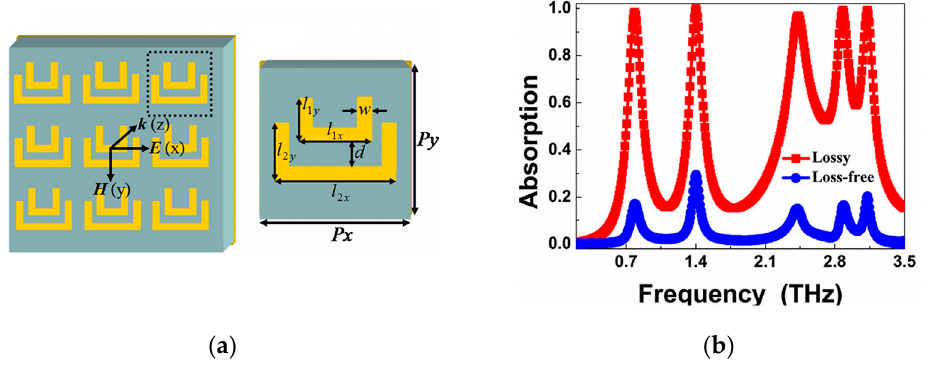
Figure 15. Five-band MPA. ( a ) Structure; ( b ) absorption curve [53].